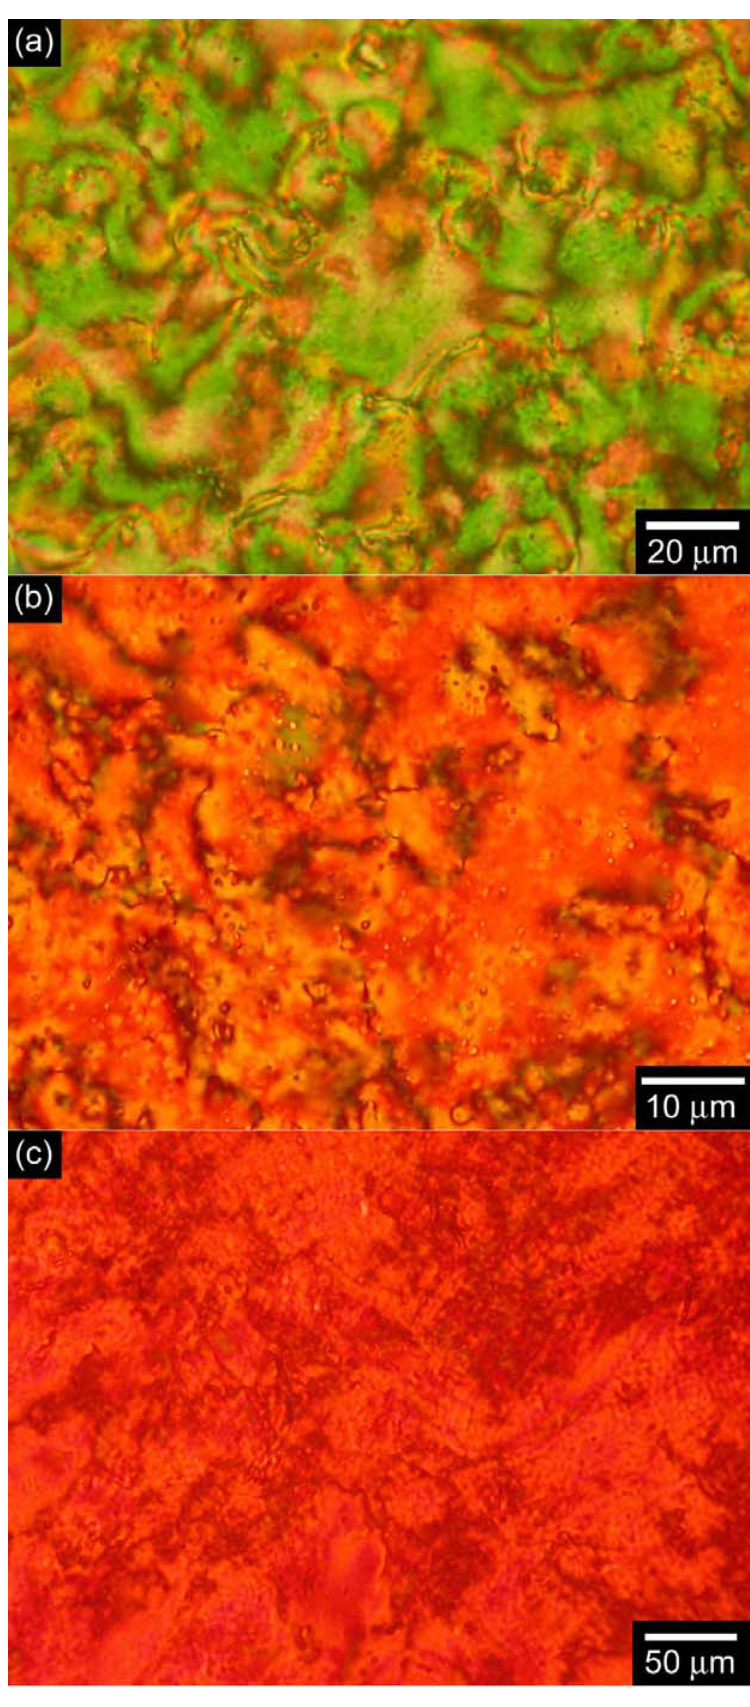
Figure 7. Polarizing optical microscopy (POM) images of LC phases of polyPLCTh ( (a) : 156 °C) polyPLC2Th ( (b) : 198 °C) and polyPLC3Th ( (c) : 200